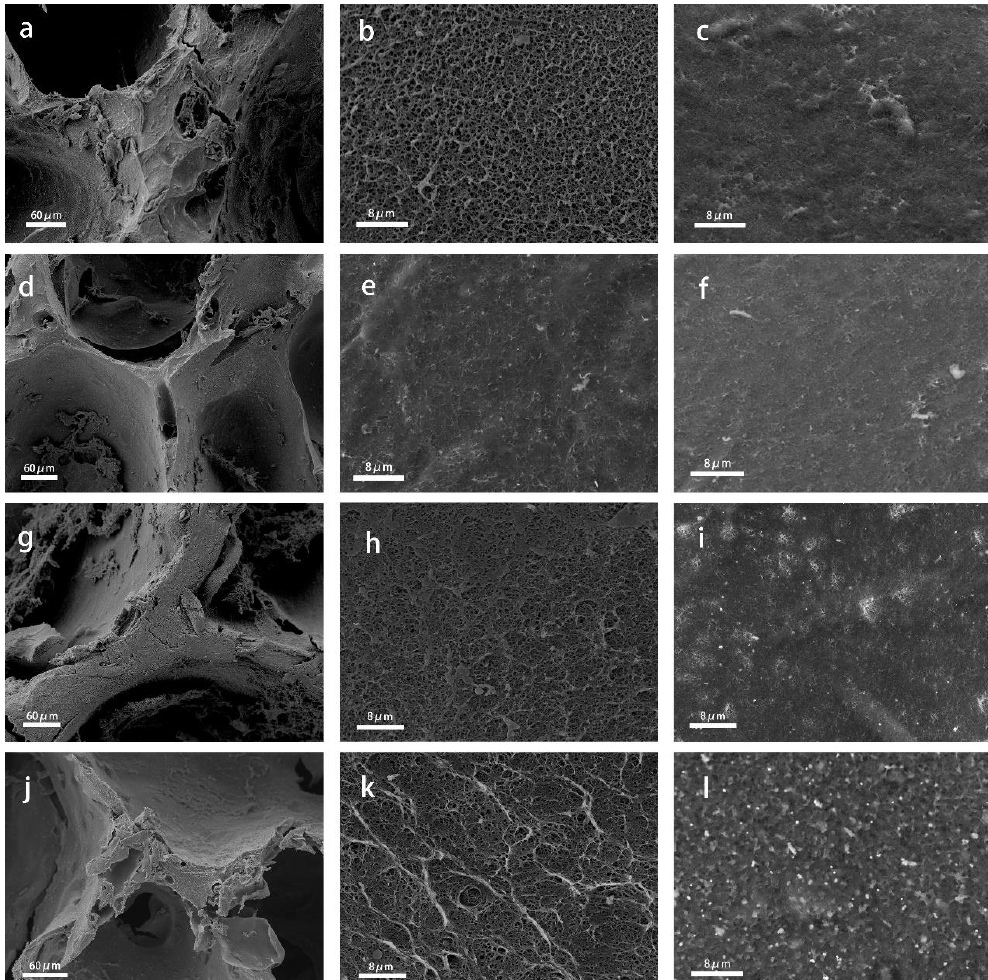
Figure 2. SEM images of cross profile and surface of VCS and AuNPs@VCS.